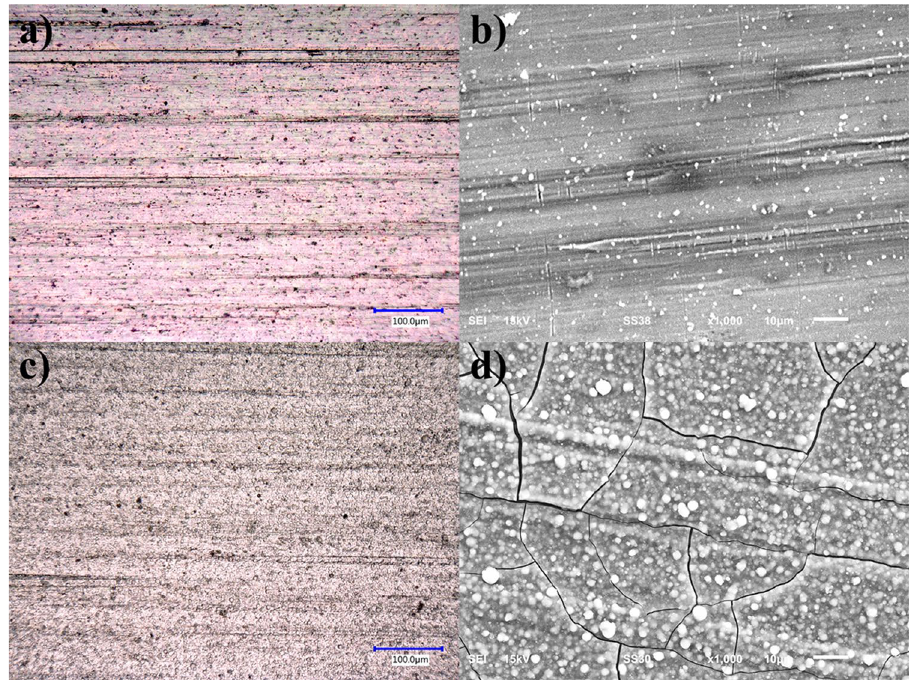
Figure 8. Optical (scale bar 100 µm) and SEM (scale bar 10 µm) micrographs of SiO 2 coatings deposited by APPJ at different times ( a,b ) 60 s and ( c,d ) 70 s,